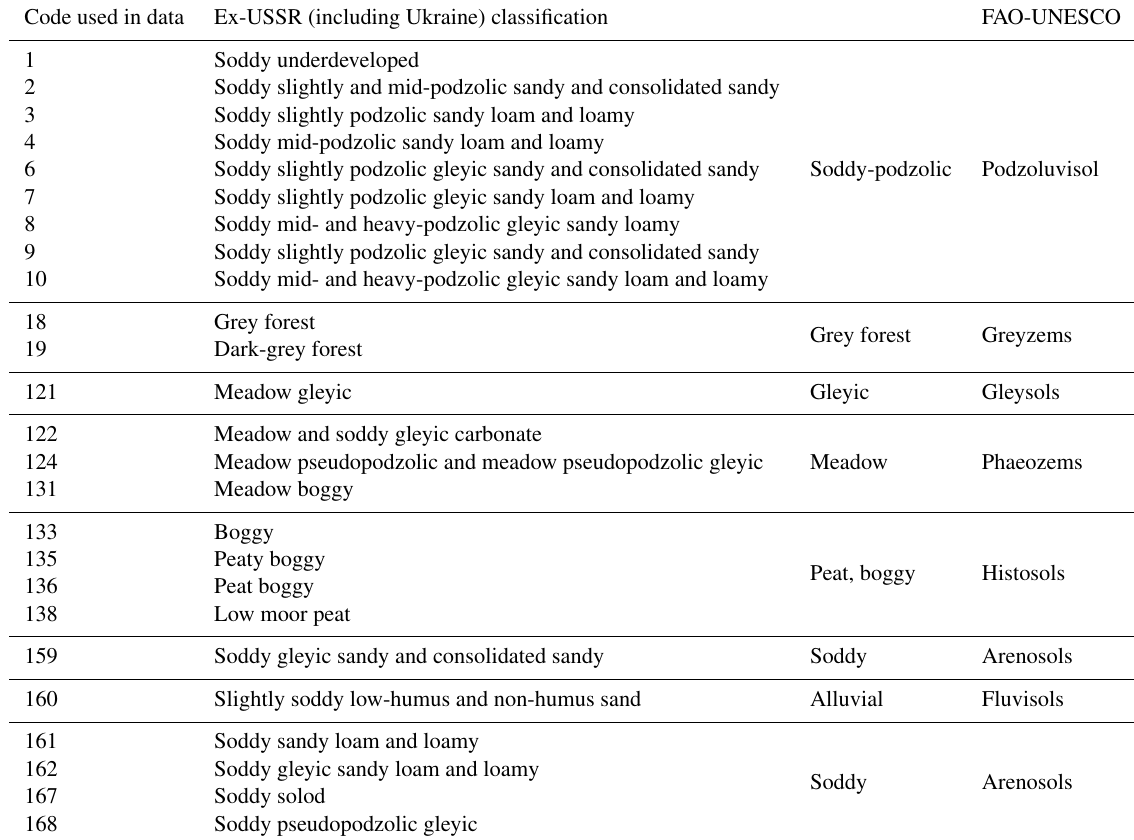
Table 2. Soil classifications appropriate to the CEZ. Code used in